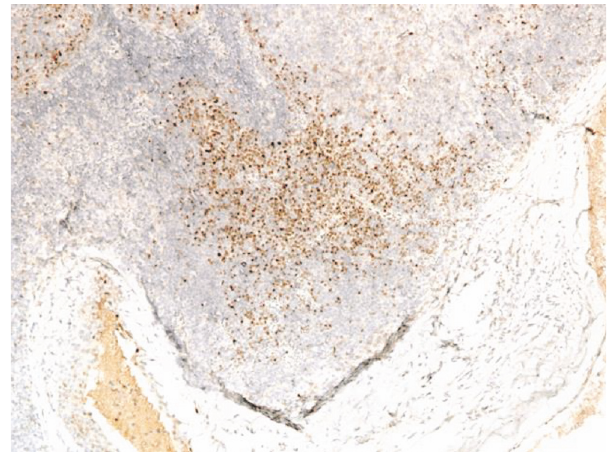
Figure 4: Mantle cell lymphoma (100x). Positive staining with CD20.